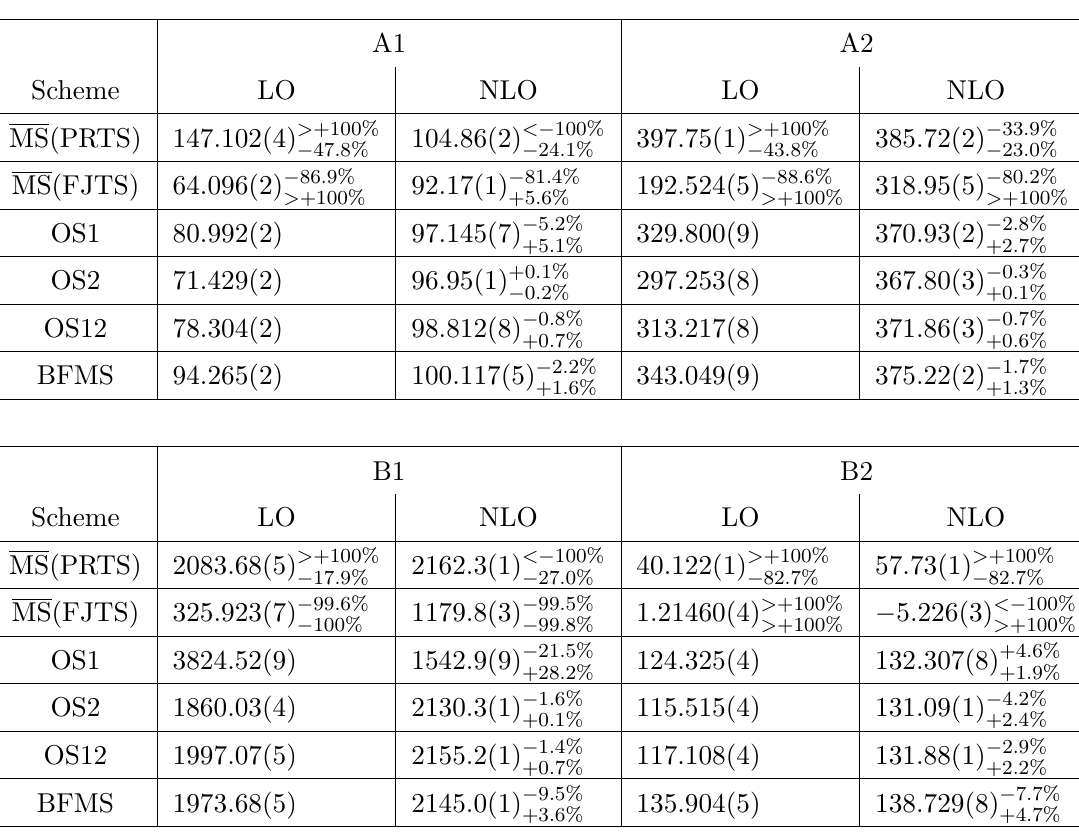
Table 8 . As in table 7, but for the decay width (cid:0) H 1 ! 4 f [MeV] of the heavy CP-even Higgs boson H 1 of the THDM.